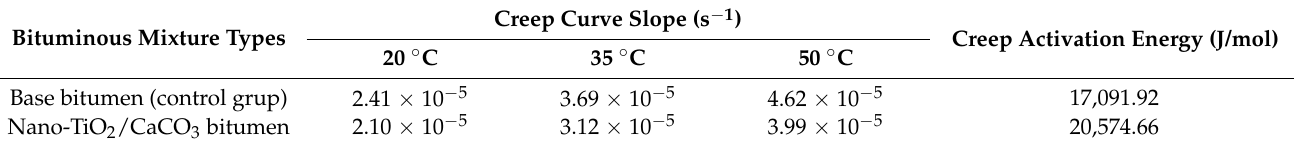
Table 7. The creep curve slope ( k ) and creep activation